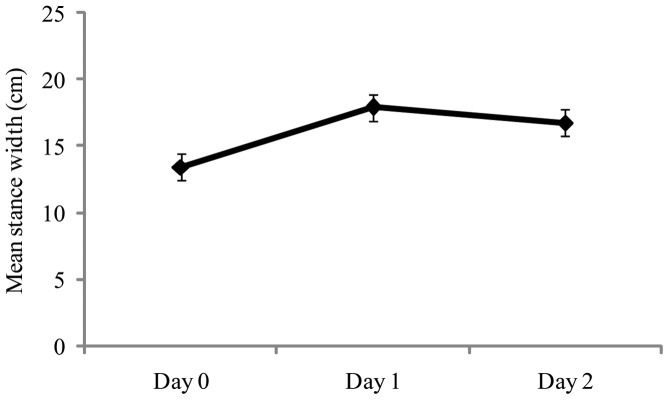
Experiment 1: Mean stance width (the distance between the midline of the heels) as a function of days.The figure illustrates the statistically significant effect of days. The error bars represent standard error of the mean.